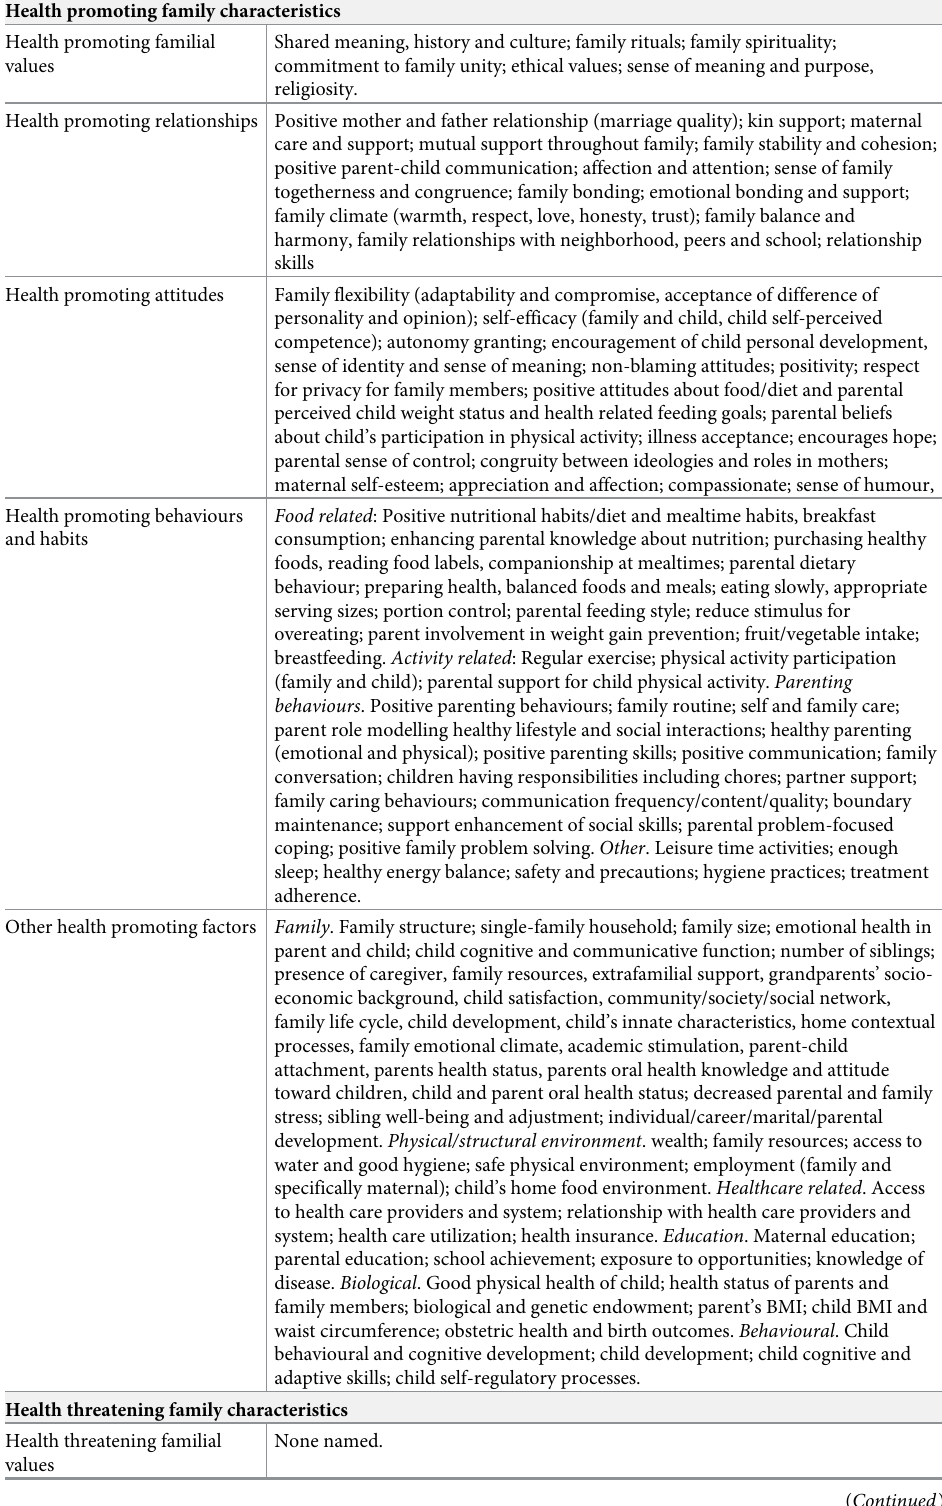
Table 5. Core characteristics of health promoting